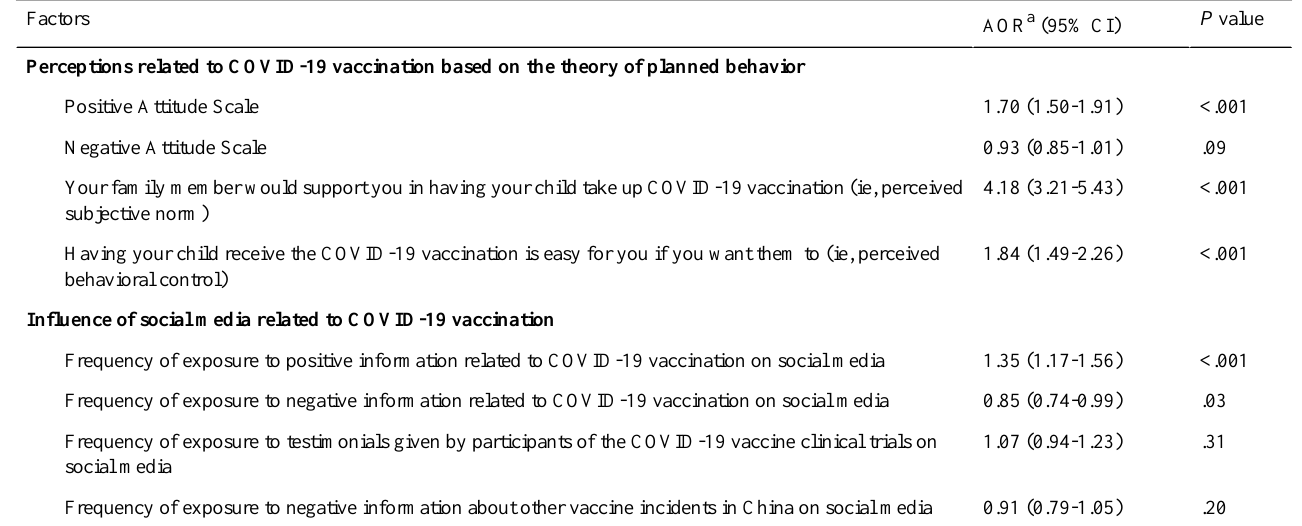
P valueAOR a (95% CI)Factors